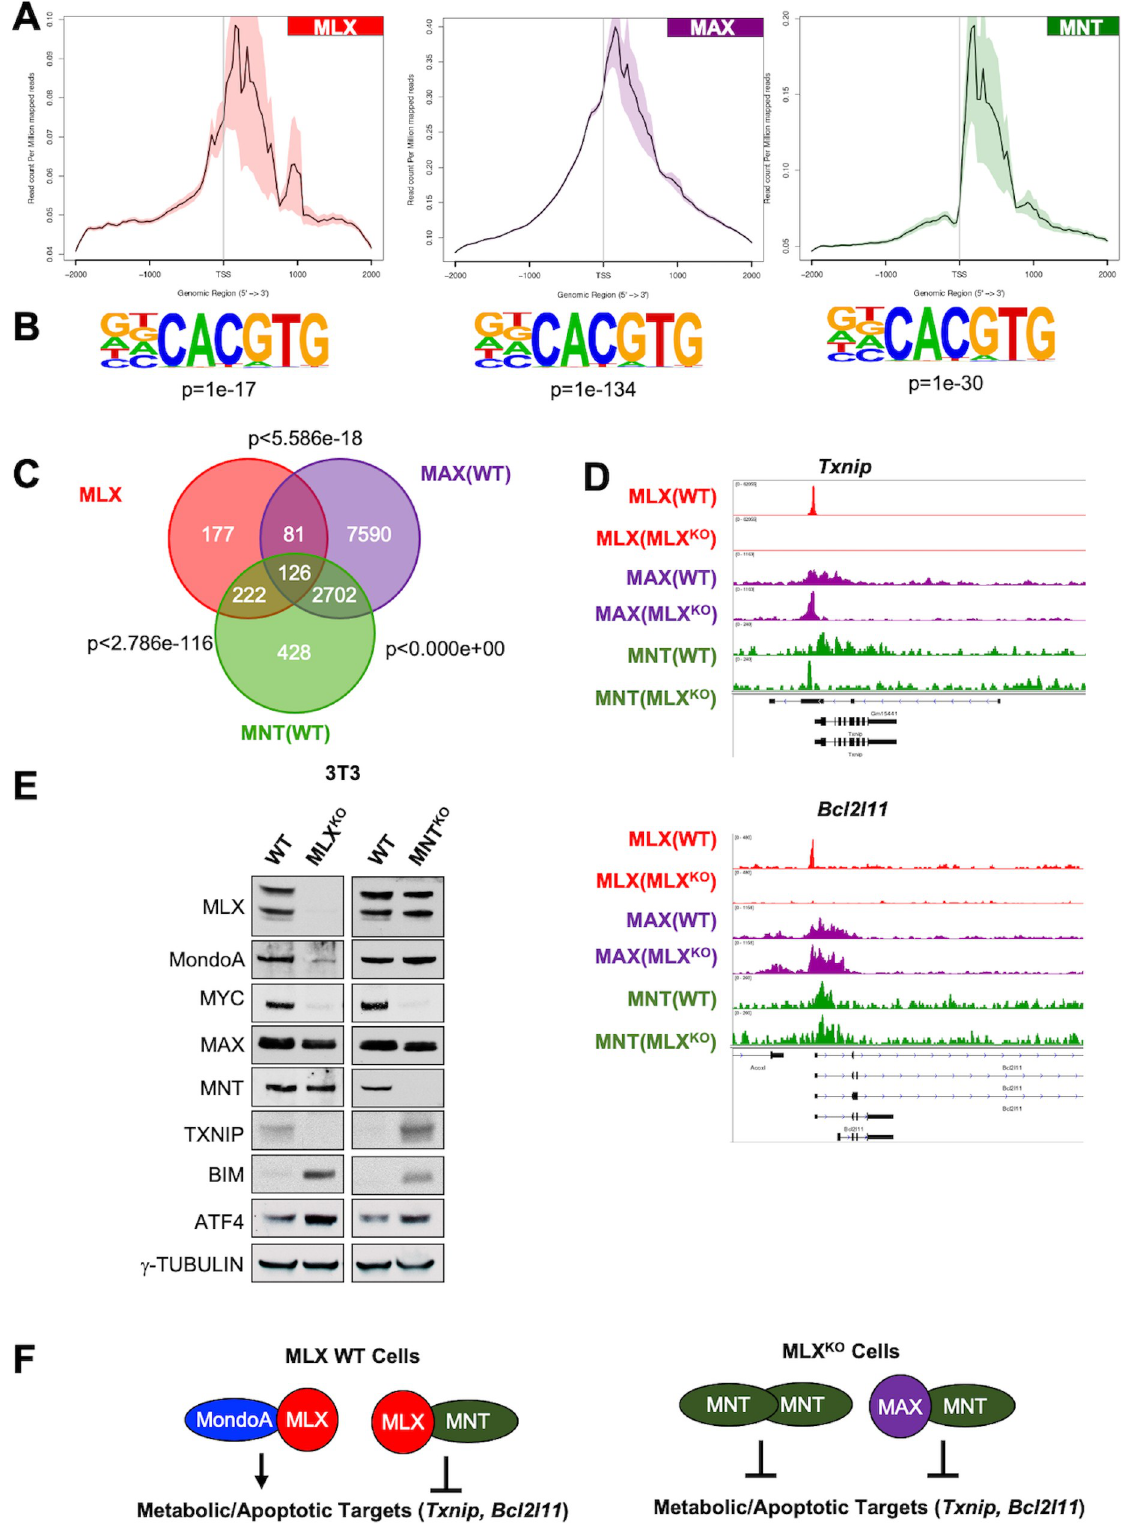
Fig 8. MLX shares transcriptional targets with MAX and MNT. (A ) Meta-plots of TSS occupancy for the indicated TFs in WT 3T3 cells. ( B ) E-Box Motif derived from HOMER analysis with the indicated p -value. ( C ) Venn diagram indicating overlap of genes bound by